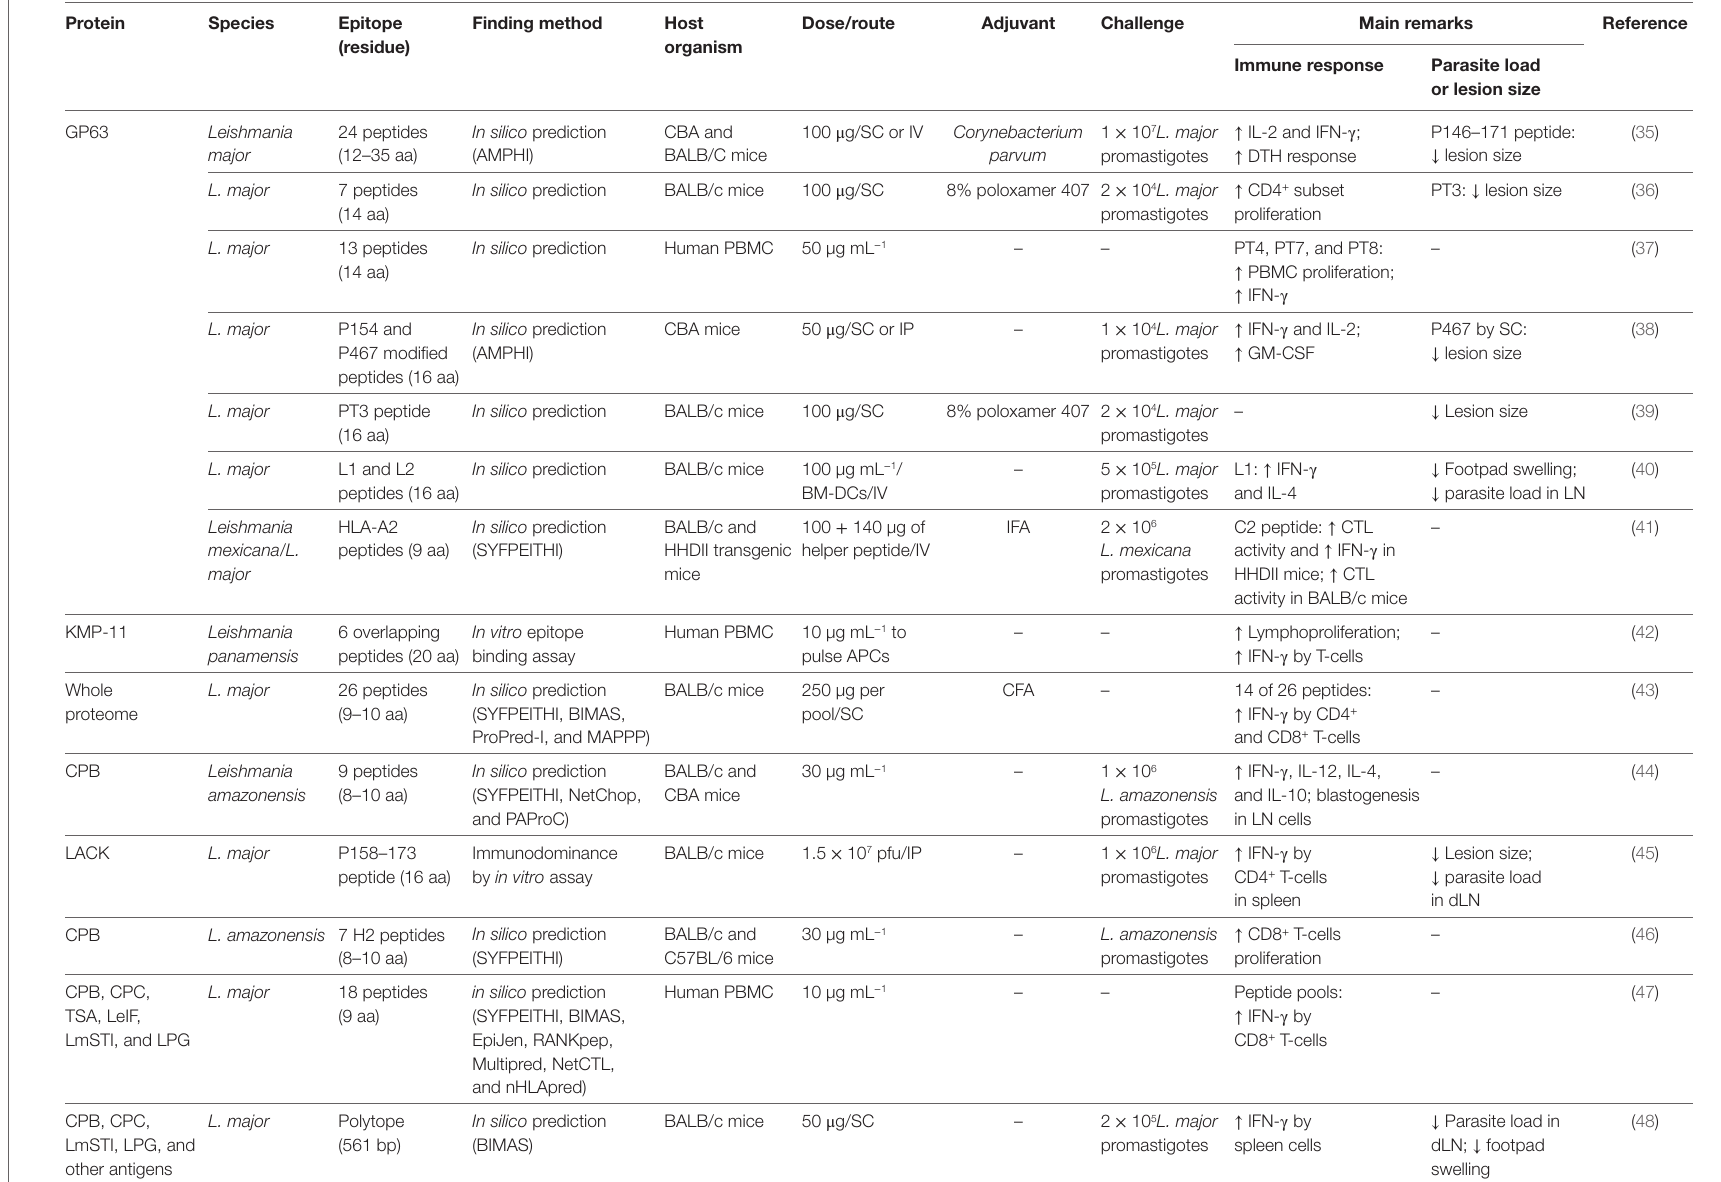
TABLe 2 | Summary of peptides evaluated as potential vaccine candidates against cutaneous leishmaniasis.